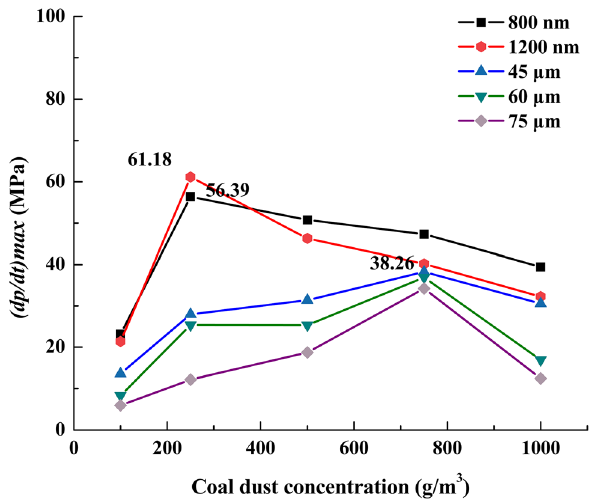
Fig. 7 Relationship between the maximum rate of pressure rise and the coal dust